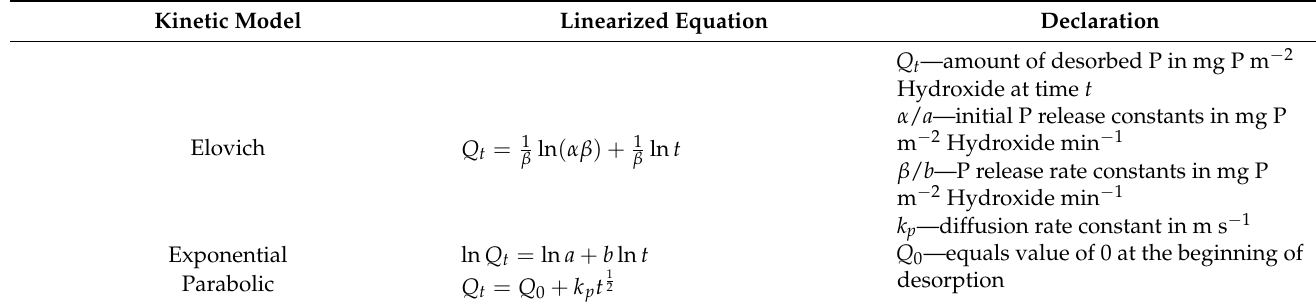
Table 2. Applied kinetic models for P